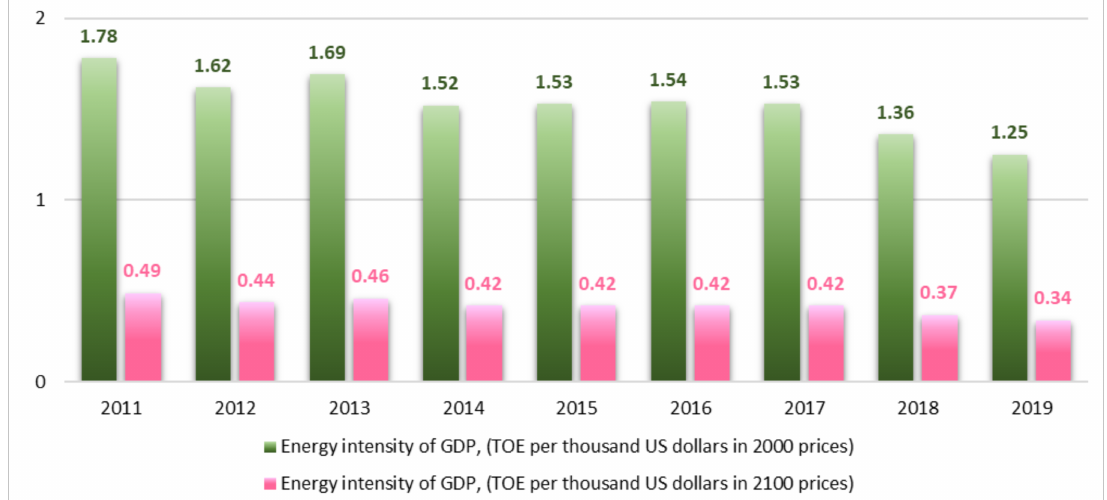
Figure 3. Dynamics of energy intensity of Kazakhstan’s GDP in 2011–2019. Source: compiled by the authors based on data from